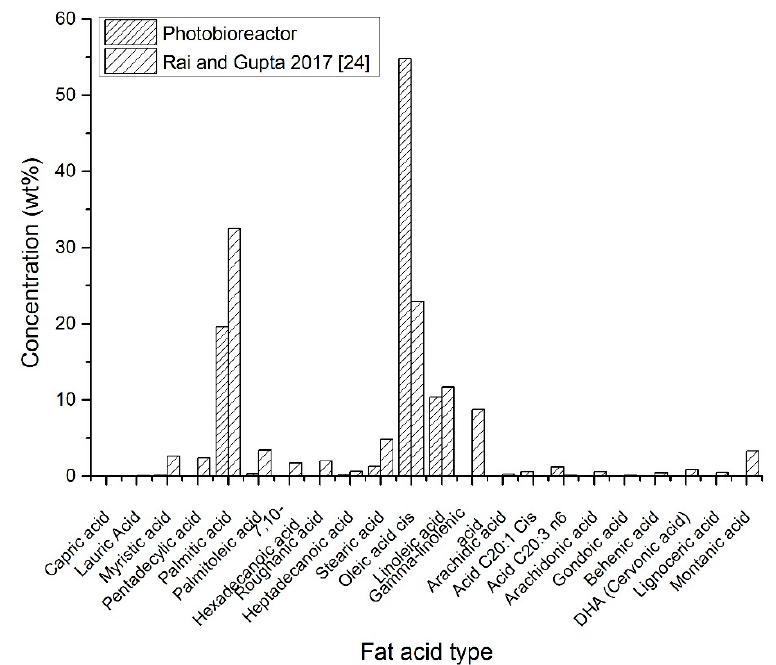
Figure 5. Comparison between Fatty Acid Methyl Esters of S. capricornutum obtained in the photobioreactor and Fatty Acid Methyl Esters produced from Scenedesmus abundans [24].